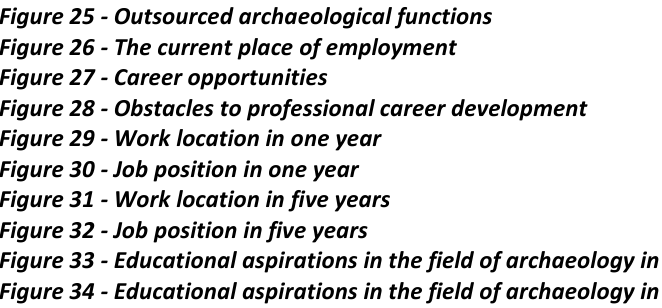
Figure 25 - Outsourced archaeological functions Figure 26 - The current place of employment Figure 27 - Career opportunities Figure 28 - Obstacles to professional career development Figure 29 - Work location in one year Figure 30 - Job position in one year Figure 31 - Work location in five years Figure 32 - Job position in five years Figure 33 - Educational aspirations in the field of archaeology in one year Figure 34 - Educational aspirations in the field of archaeology in five